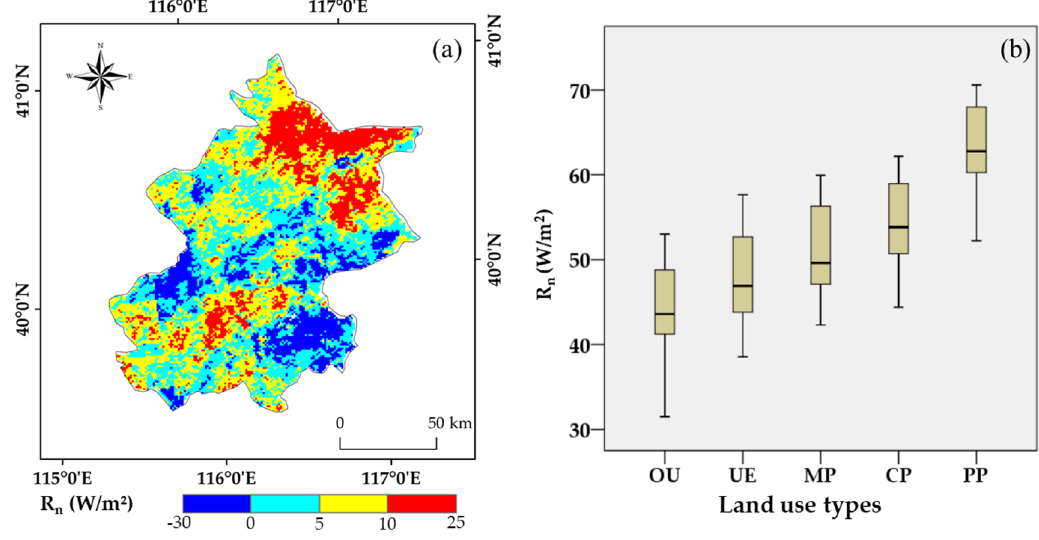
Figure 4. Net radiation (R n ) in Beijing. ( a ) Spatial difference of R n from 2000 to 2015; ( b ) Statistical feature values of the five land use types for R n from 2000 to 2015.